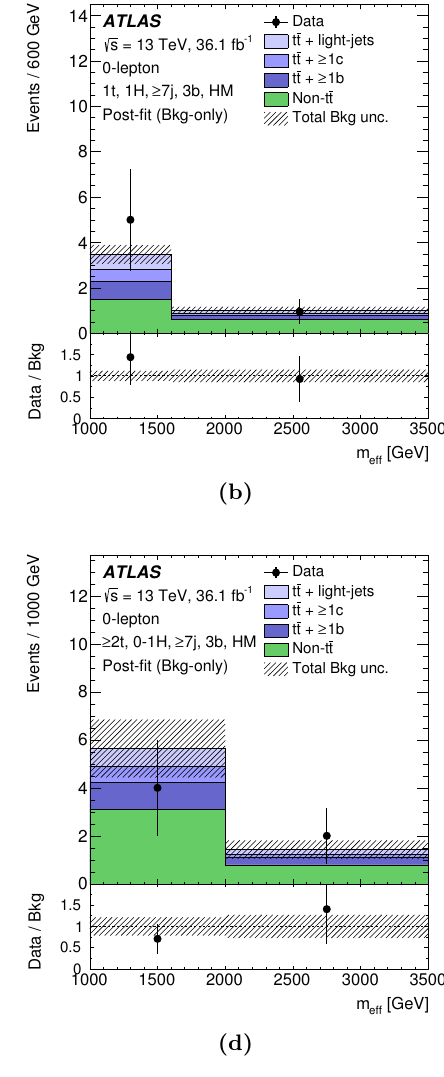
Figure 12. Comparison between the data and prediction for the m e(cid:11) distribution in some of the most sensitive search regions in the 0-lepton channel, before and after performing the combined (cid:12)t to data in the 0-lepton and 1-lepton channels (\Pre-(cid:12)t" and \Post-(cid:12)t", respectively) under the background-only hypothesis. Shown are the (1t, 1H, 7j, 3b, HM) region (a) pre-(cid:12)t and (b) post- (cid:21) (cid:12)t, and the ( 2t, 0{1H, 7j, 3b, HM) region (c) pre-(cid:12)t and (d) post-(cid:12)t. In the pre-(cid:12)t (cid:12)gures the (cid:21) (cid:21) expected T (cid:22) T signal (solid red) corresponding to m T = 1 TeV in the T doublet scenario is also shown, added on top of the background prediction. The small contributions from t (cid:22) tV , t (cid:22) tH , single- top, W=Z +jets, diboson, and multijet backgrounds are combined into a single background source referred to as \Non- t (cid:22) t ". The last bin in all (cid:12)gures contains the over(cid:13)ow. The bottom panels display the ratios of data to the total background prediction (\Bkg"). The hashed area represents the total uncertainty of the background. In the case of the pre-(cid:12)t background uncertainty, the normalisation uncertainty of the t (cid:22) t + 1 b background is not included. (cid:21)